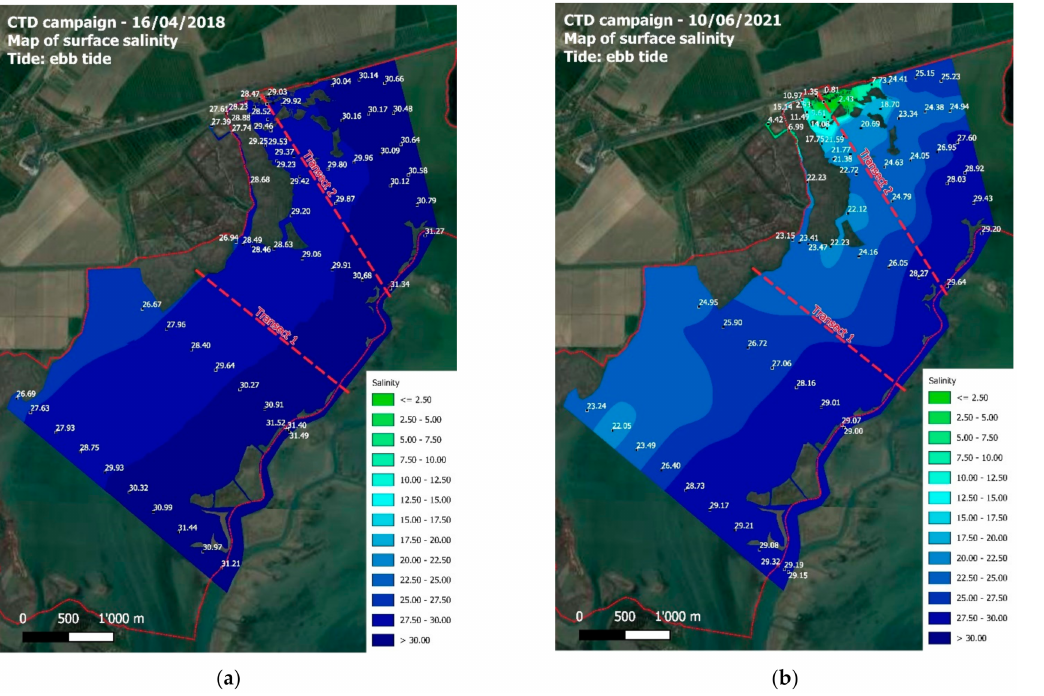
Figure 9. Map of Kriging interpolation performed on results of CTD campaigns: ( a ) campaign of 16 April 2018 with no fresh water input; ( b ) campaign of 10 June 2021 with a discharge of 1000 ls − 1 . In both maps, the surface layer (0–30 cm) is